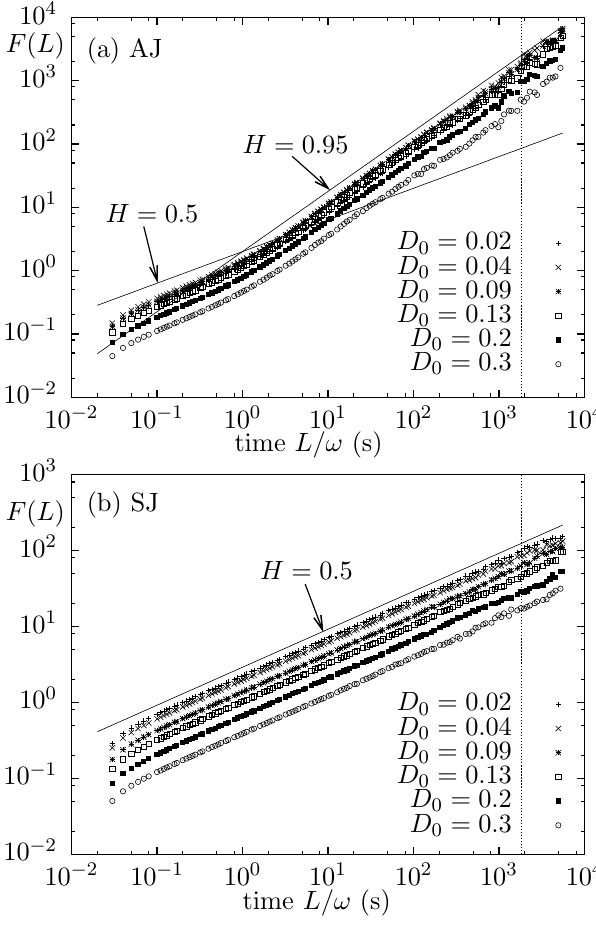
Fig. 7. Detrended Fluctuation Analysis applied to random walks driven by events derived from U x velocity component. (a) AJ rule. (b) SJ rule. The results for different thresholds D 0 are reported. The continuous lines are reported as an eye-guide. The vertical dotted line corresponds to the averaging time T =